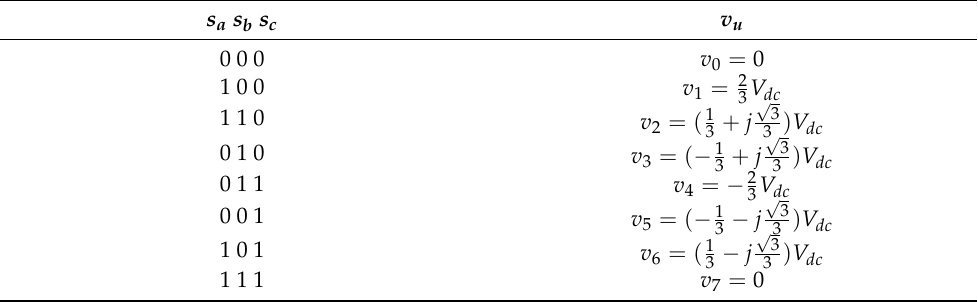
Table 1. Possible switching states and related voltage space vectors used in two-level three- phase